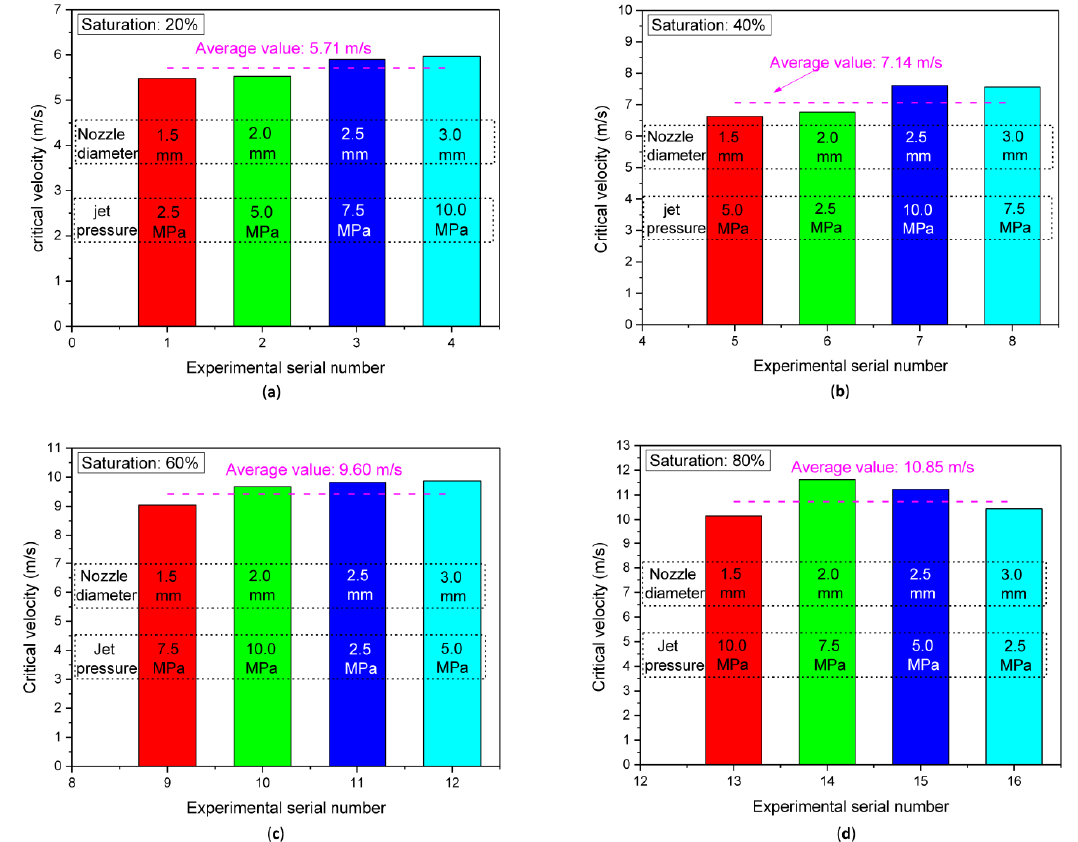
Figure 5. Variation of the critical breaking velocities with nozzle diameter and jet pressure under various NGH saturations: ( a ) NGH saturation is 20%. ( b ) NGH saturation is 40%. ( c ) NGH saturation is 60%. ( d ) NGH saturation is 80%. The different colors red, green, dark blue and light blue in the figure indicate that the nozzle diameters are 1.5 mm, 2.0 mm, 2.5 mm and 3.0 mm respectively.